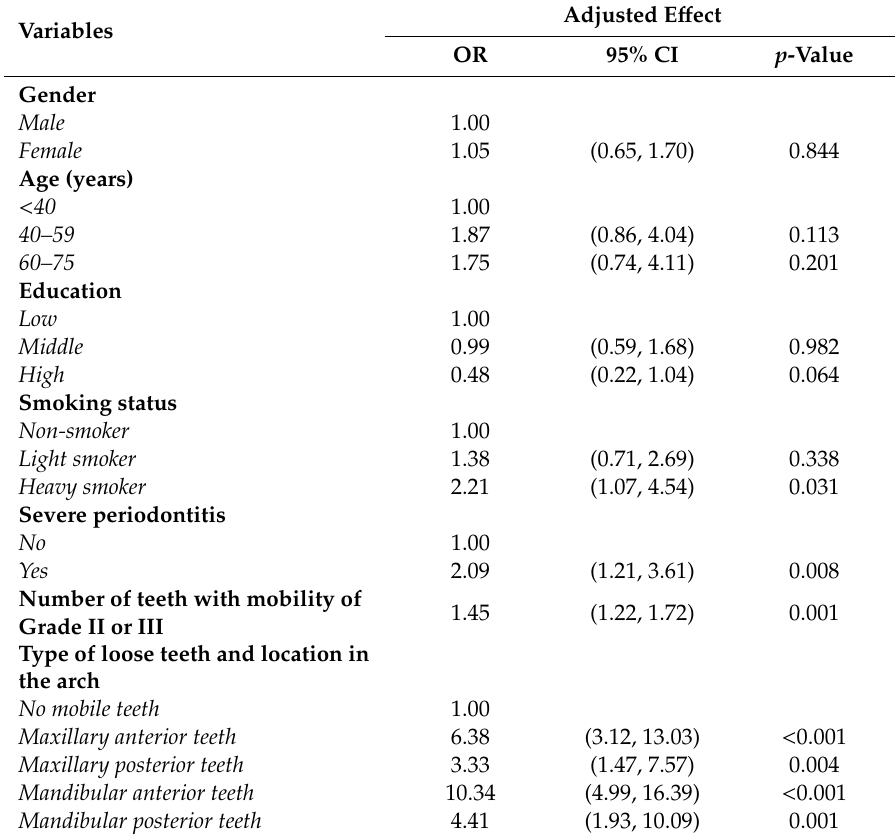
Table 5. Multivariate logistic model, considering self-perception of tooth mobility as the outcome variable (Hosmer and Lemeshow χ 2 = 8.806, df = 8, p =